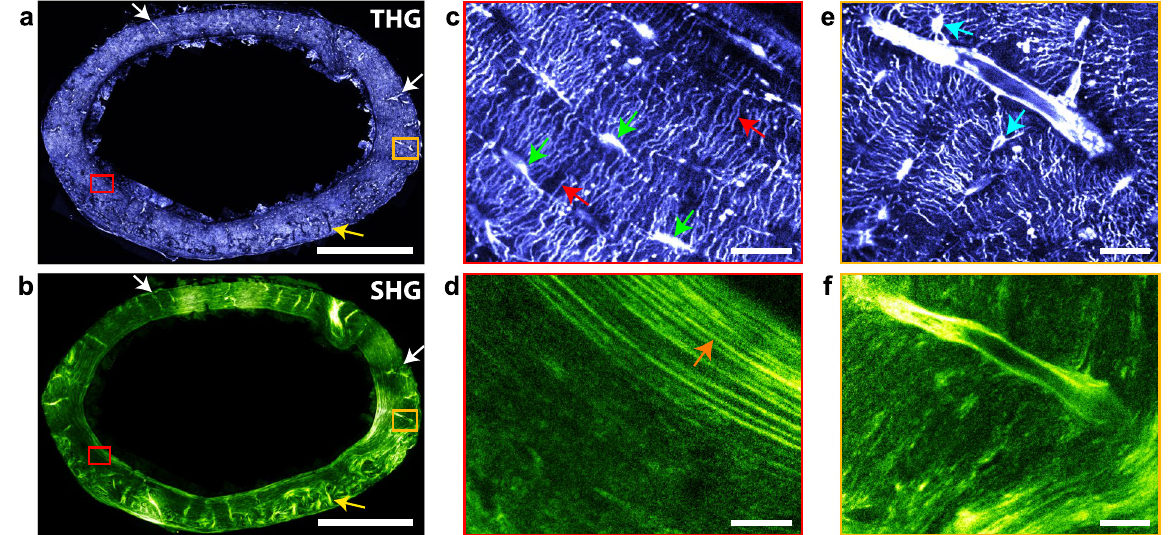
Figure 5. Imaging mouse bone structures at the organ scale. Whole section of a mouse femur imaged a few microns below the sample surface with THG ( a ) and SHG ( b ). Tubular structures of diameter consistent with that of vascular channels (~11 ± 3 µ m), appear either with a positive (white arrows) or negative (yellow arrow) contrast in the THG images. Scale bar, 500 µ m. Total imaging time, 333 s (including overlaps between images). ( c ) (resp. ( d )), zoom into the red rectangle area in ( a ) (resp. ( b )), showing thin and elongated lacunae along the tangential direction, i.e. parallel to the endost and periost (green arrows), canaliculi mainly oriented along the radial direction (red arrows) in the THG image, and a collagen lamellar periodic structure in SHG (orange arrow). Scale bar, 20 µ m. ( e ) (resp. ( f )), zoom into the orange rectangle area in ( a ) (resp. ( b )), showing a vascular channel, rounder lacunae (blue arrows) and a more disordered collagen